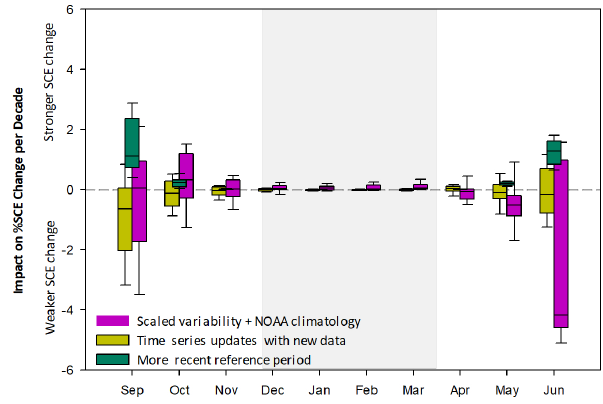
Figure 4. Change in Arctic SCE (percent per decade) for May since 1981 relative to three reference periods (P1, P2, P3; see Table 2) and scaled versus unscaled datasets since 1981 through the year noted on the x axis. The impacts of year-to-year increases in time series length, reference period differences, and changes due to dataset ad- justments are noted.